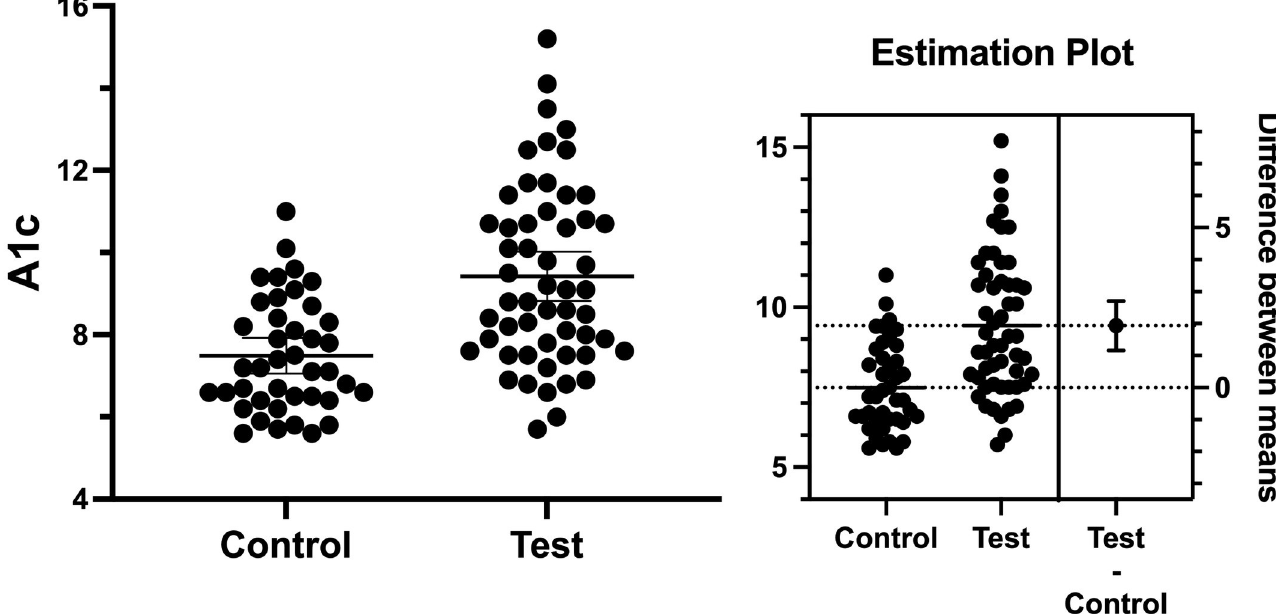
Fig 4. The value of A1c in both groups. Mean values of A1c in the test group and control group were 9.42 and 7.48, yielding the mean difference between the groups (left) as 1.93 ± 0.39 (95%CI 1.159–2.277 and p = 0001).